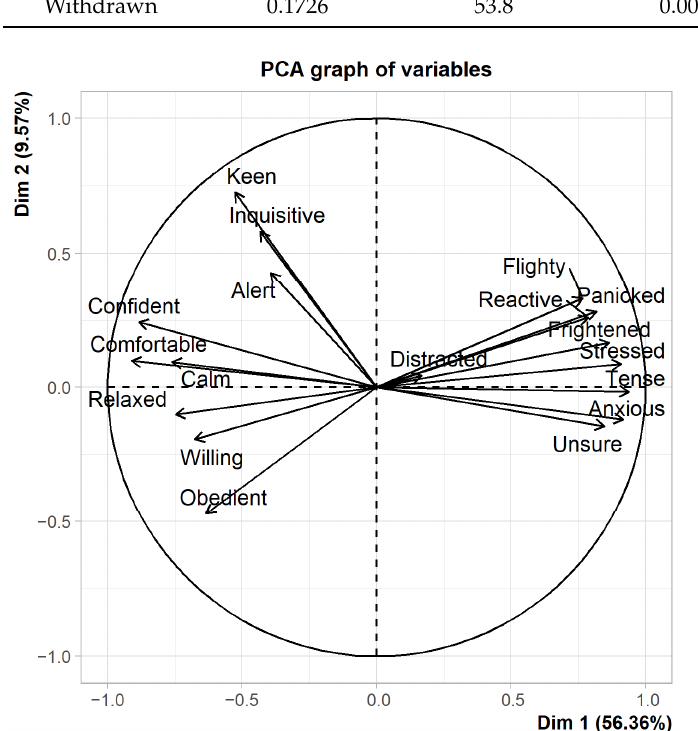
Figure 3. Loading plot of QBA fixed list descriptors along the first two PCA components for Asses- sor